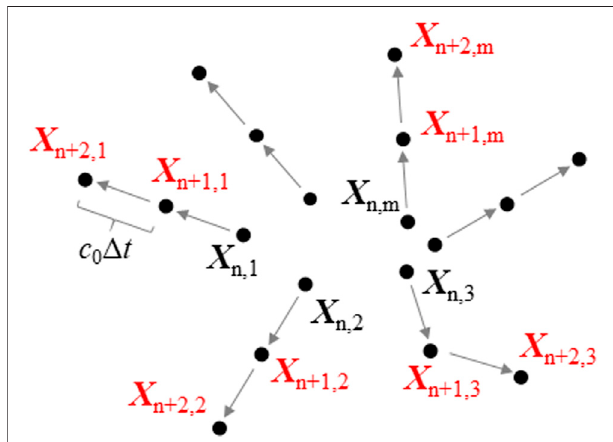
FIGURE 3 | Schematic illustration of radiative transfer theory, simulated using a very large number of particles. When the propagation direction, q m , is known, the future locations of the m th particle ( X n+1,m , X n+2,m , ... ) are easily predicted from its current location X n,m , that is X n+1,m (cid:2) X n,m + c 0 Δ t q m and X n+2,m (cid:2) X n,m + 2 c 0 Δ t q m , if scattering does not occur. If scattering occurs, the propagation direction is newly given by the probability density as shown for X n+1,3